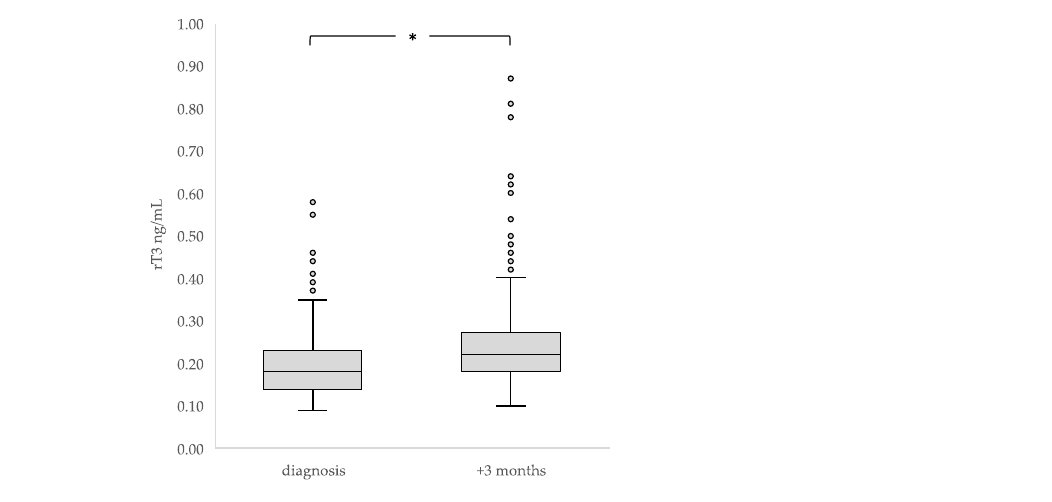
Figure 2. Median concentrations and interquartile ranges of TSH, FT4 and rT3 in children at diagnosis and three months after diagnosis ( n = 284). * The boxes show the IQR divided by the median, dots denote outliers.